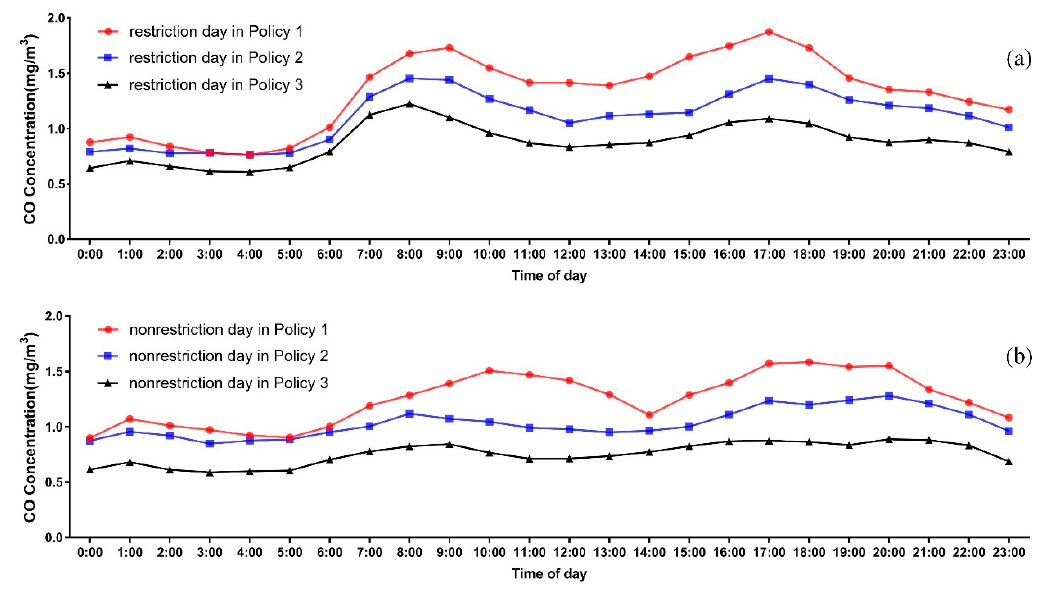
Figure 3. Comparison of CO concentration on restriction days and nonrestriction days: ( a ) restriction day; ( b ) nonrestriction day.